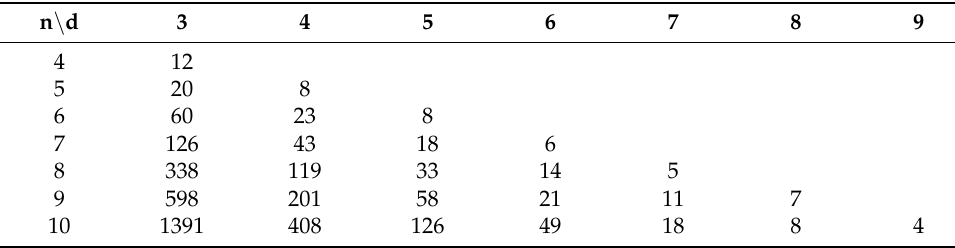
Table 6. Lower bounds for A GC , NL , EP ( n , d ) .